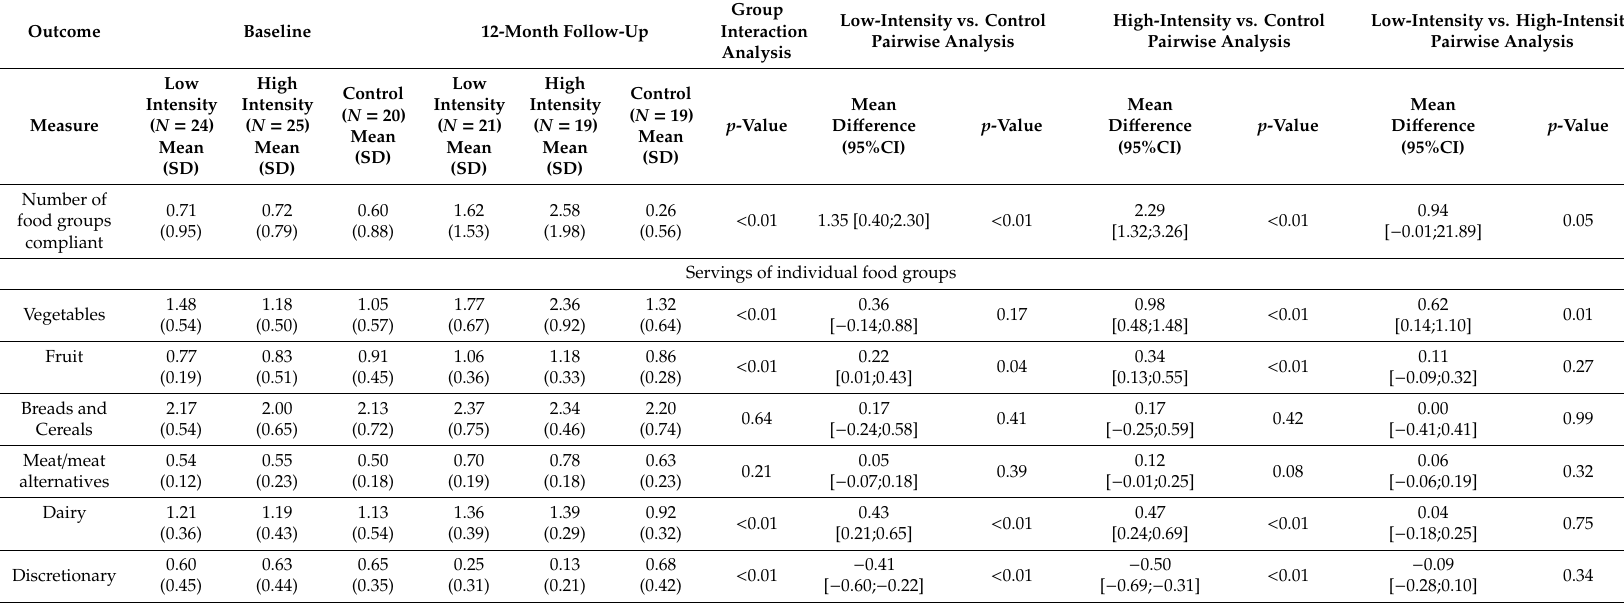
Table 4. Mean number of food groups compliant with nutrition guidelines, and servings of individual food groups at baseline and 12-month follow-up a.